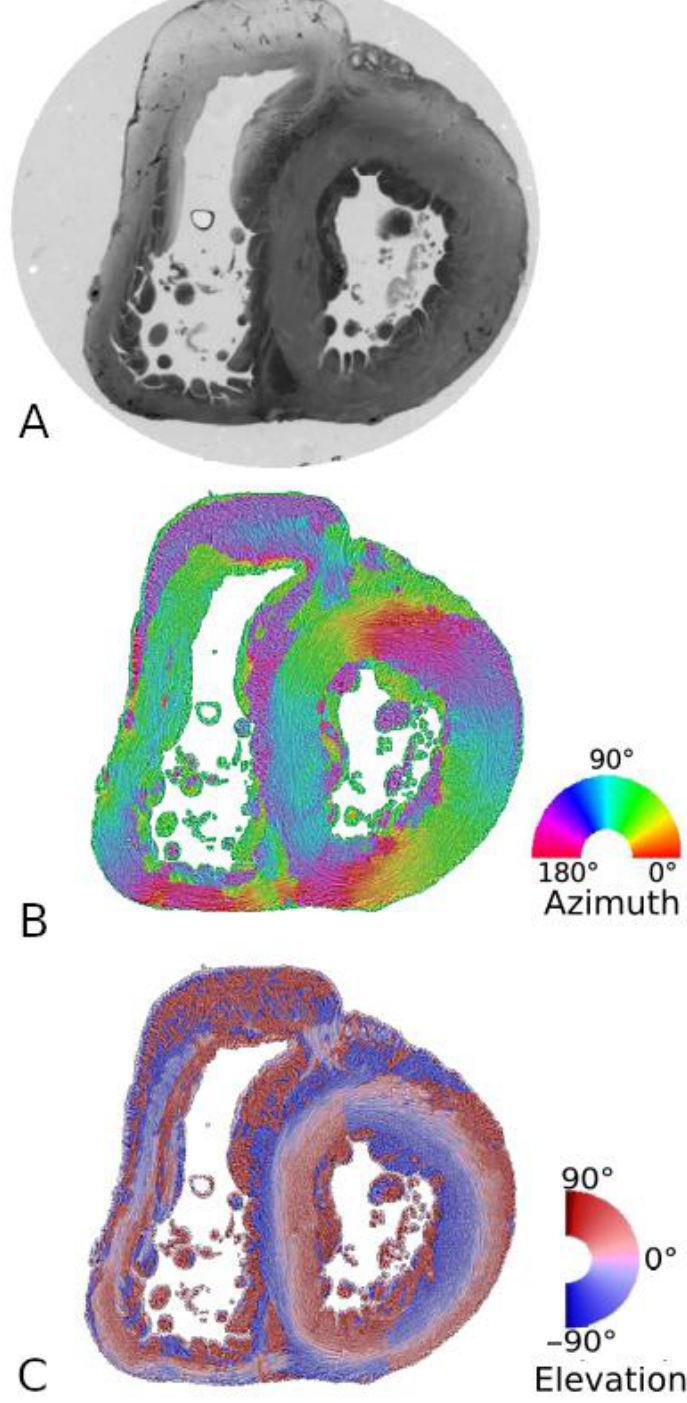
Figure 3. Example of PLI-MMA orientation maps. ( A ): Short-axis section of a neonatal heart, as seen in simple transmitted light after embedding in MMA resin. ( B ): Same section, colour-coded azimuth map with superimposition of LIC texture. ( C ): Colour-coded elevation map with superimposition of LIC texture. The checkered appearance (colour discontinuities at the superior and inferior part of the ventricular wall) visible on the elevation maps are due to the sudden change from 90 ◦ to − 90 ◦ , when the azimuth angle ranges from 0 ◦ to 180 ◦